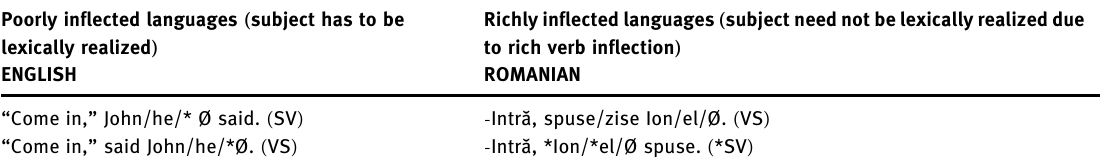
Table 2: Subject of the quoting verb Poorly in fl ected languages ( subject has to be lexically realized